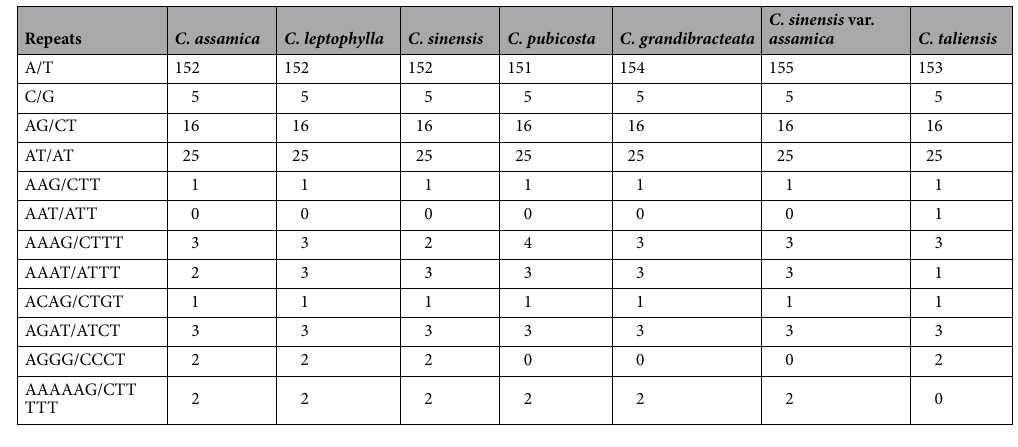
Table 1. Frequency of classified SSR repeat types in 7 cp genomes.